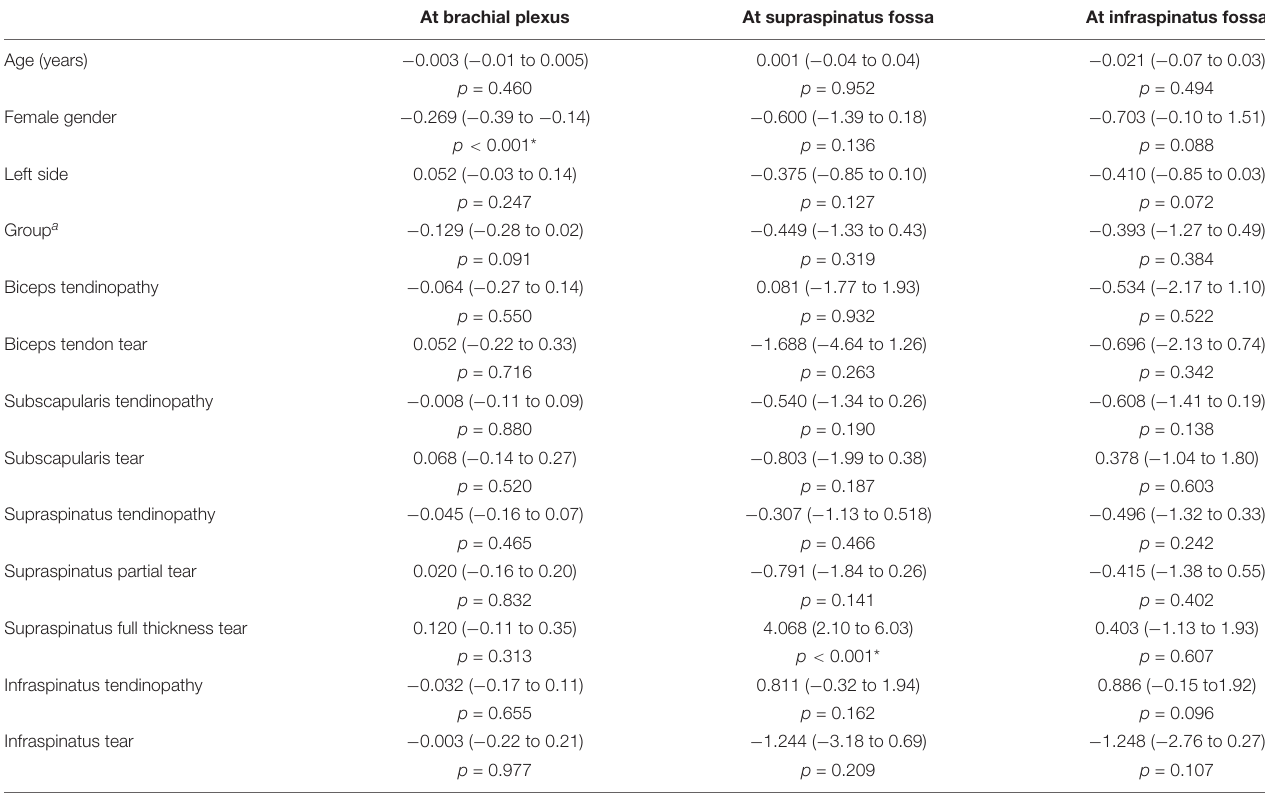
TABLE 3 | Associations among suprascapular nerve cross-sectional area measurements and the clinical characteristics (expressed by β coefficients and their 95% confidence intervals). At brachial plexus At supraspinatus fossa At infraspinatus